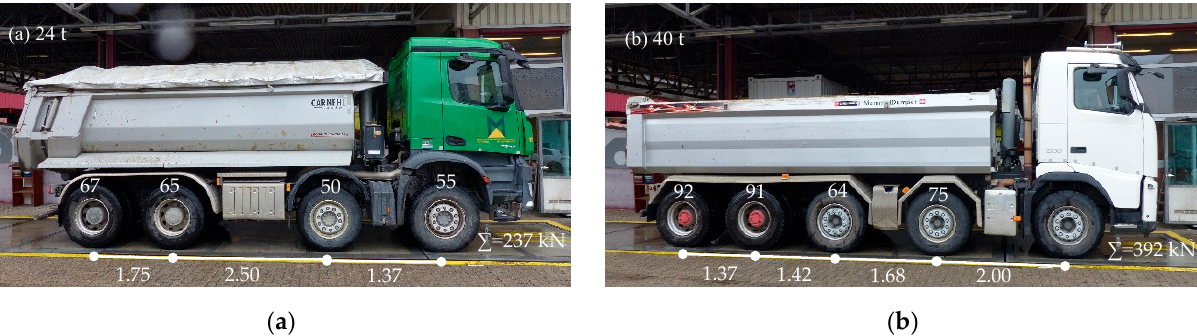
Figure 8. Axle loads (kN) and axle distances (m) of the trucks in the reference measurements: ( a ) truck with a total mass of 24 t; ( b ) truck with a total mass of 40 t.